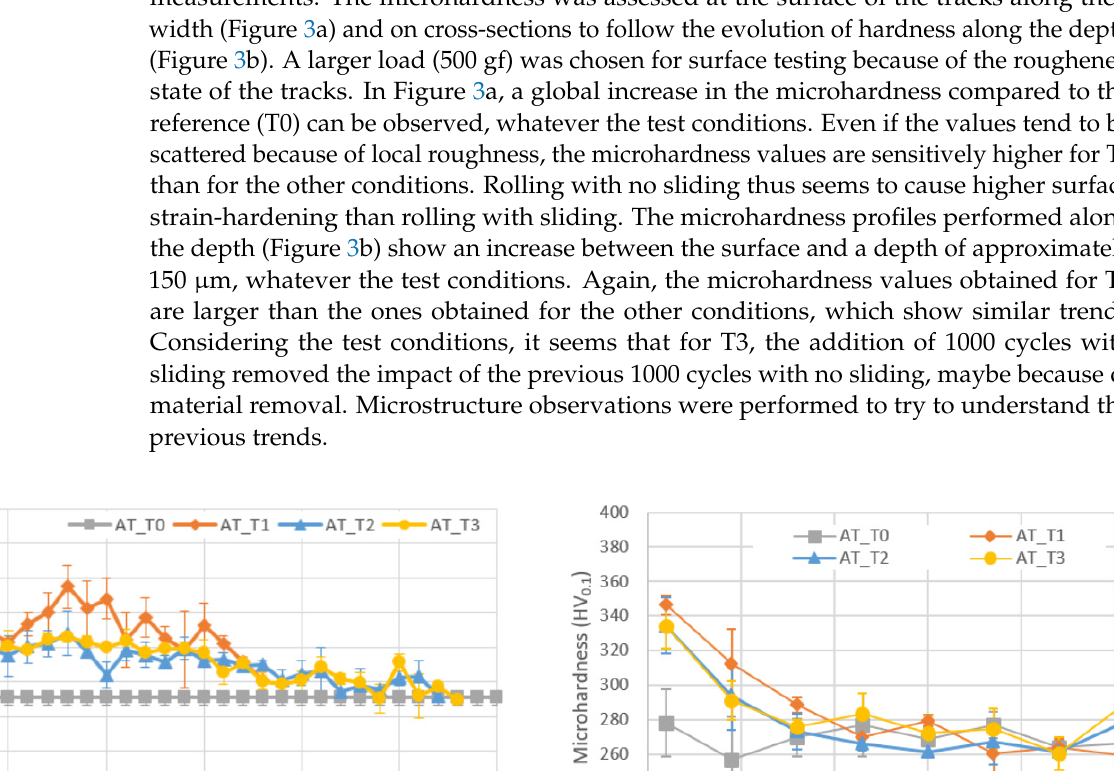
( b ) Figure 4. ( a ) SEM image of the pearlitic microstructure (AT-T0) and ( b ) interlamellar spacing for Ring AT. By using the EBSD measurements, inverse pole figure (IPF) maps of ferrite were cou- pled with Index Quality (IQ) maps to visualize orientations and the underlying micro- structures (as cementite is not indexed, it appears in black in the IQ map). Kernel Average Misorientation (KAM) maps were also computed to observe the evolution of local grain misorientation with deformation. Both types of maps are shown for all the tested condi-